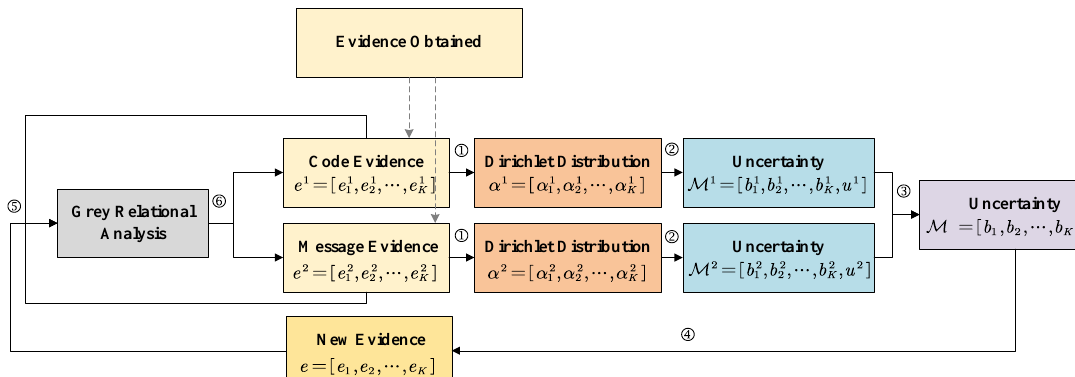
Figure 3. The process of trusted multi-view